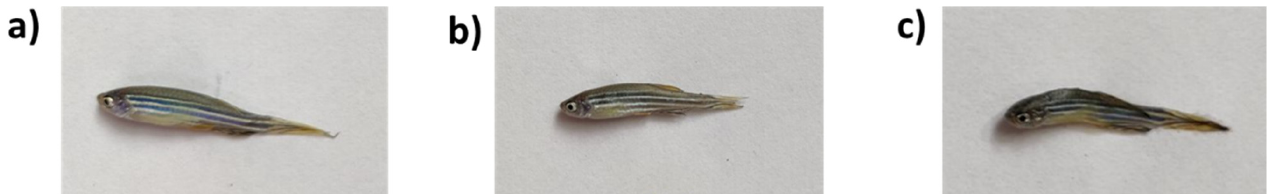
Figure 8. Phenotypic changes observed in zebrafish exposed to silver nanoparticles. ( a ) control; ( b ) exposed to 10 µg; ( c ) exposed to 20 µg.